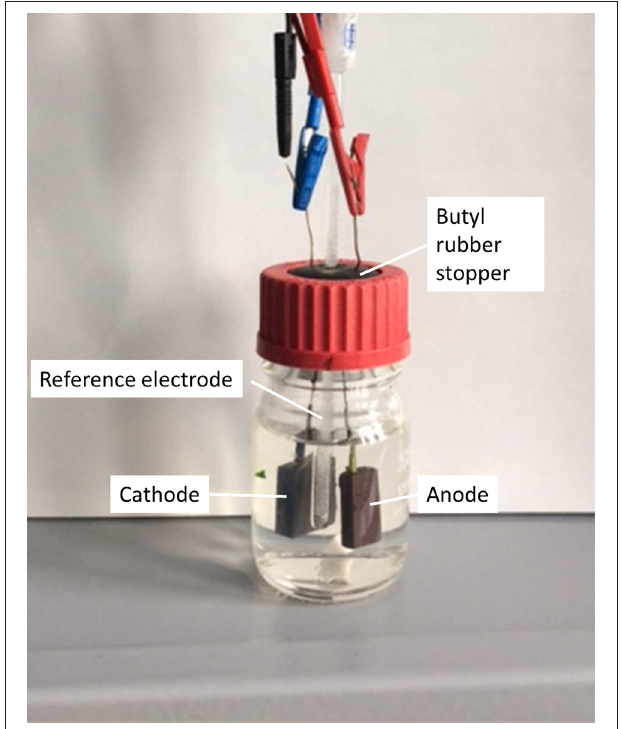
FIGURE 1 | MEC-setup used for electrochemical